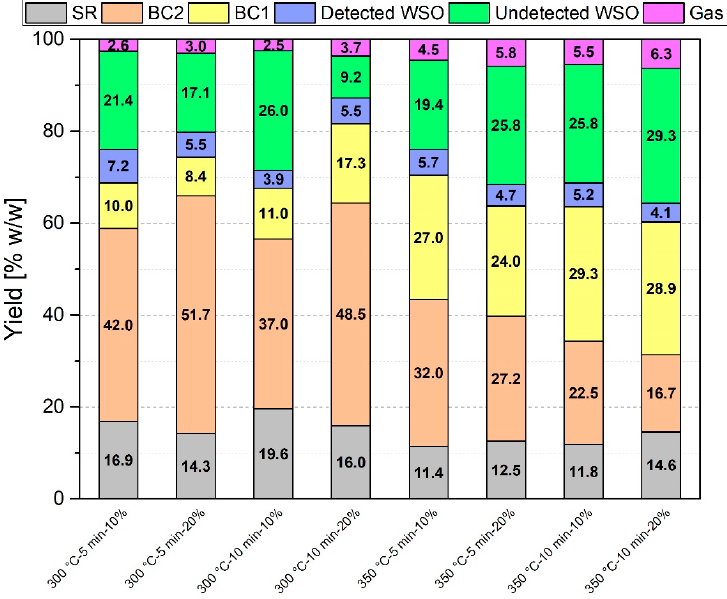
Figure 4. Dry-basis mass yields under different reaction conditions.